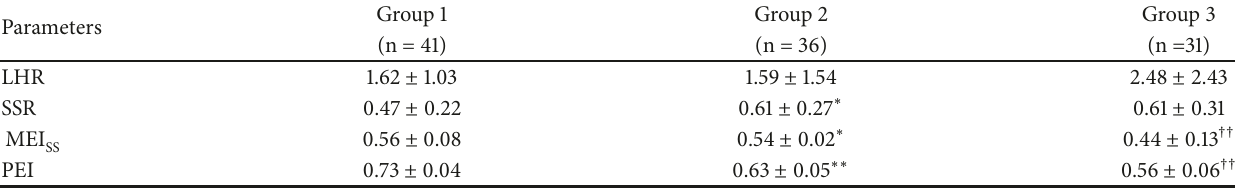
Table 2: Comparison of computational parameters for autonomic function assessment in three groups of testing subjects.